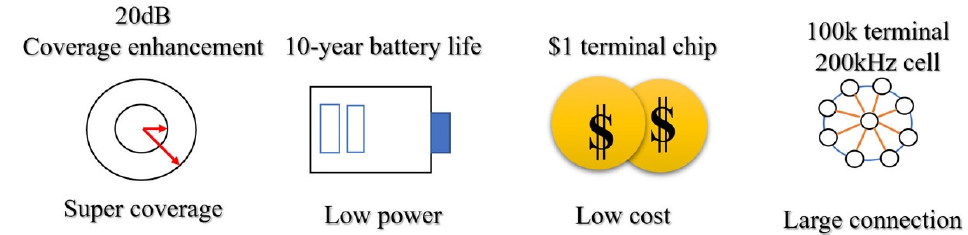
Figure 14. IoT feature requirements.